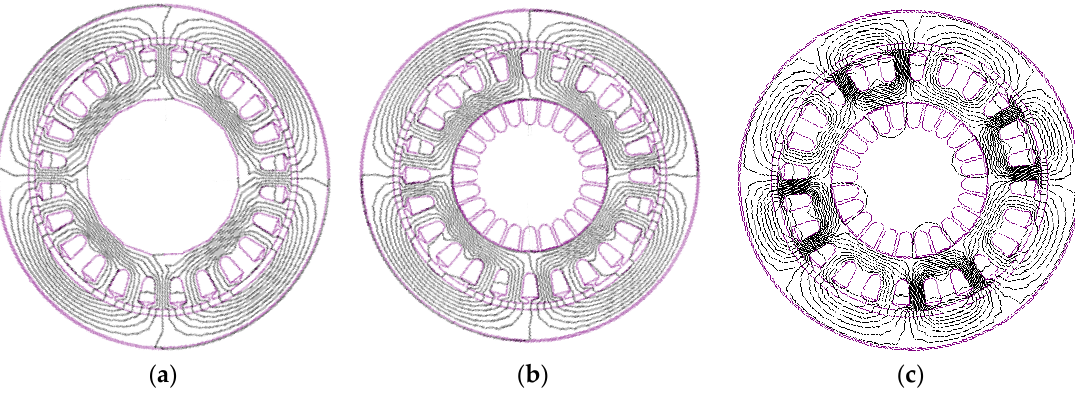
Figure 6. Armature magnetic field distributions: ( a ) T-PMSM; ( b ) T-TWPMSM; ( c ) N-TWDDPMSM.